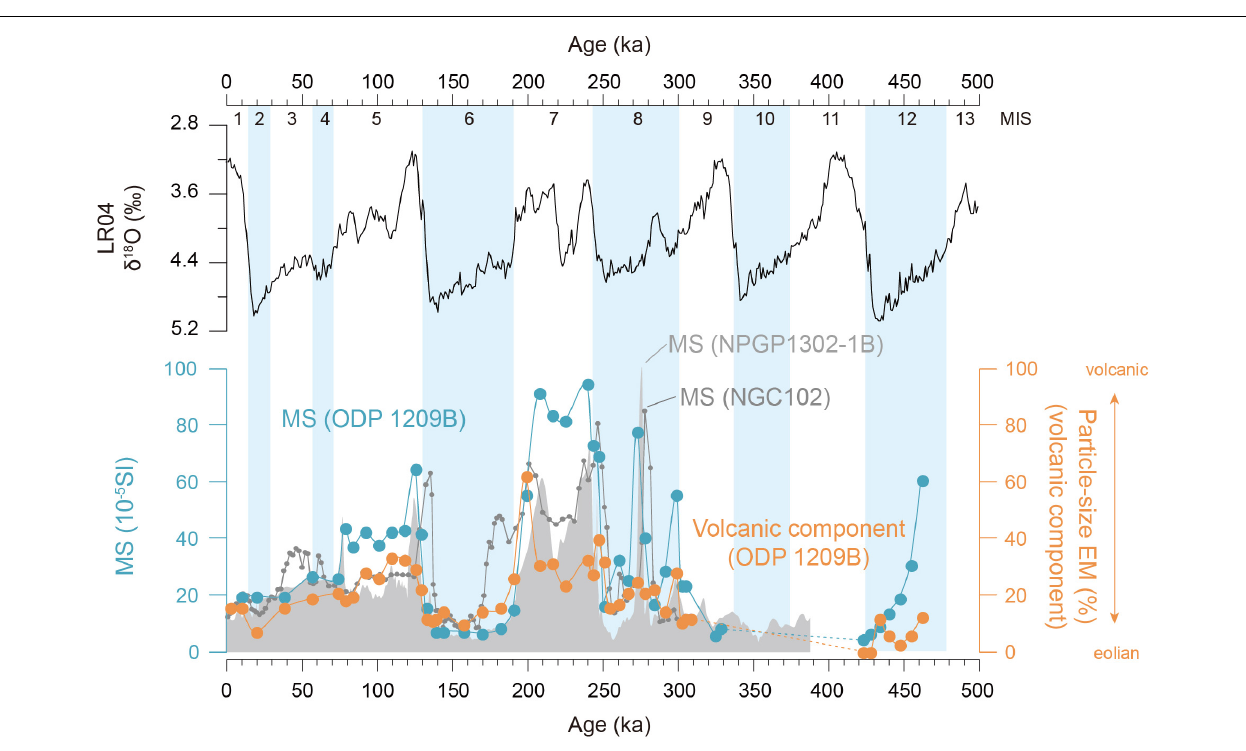
FIGURE 7 | Comparison of global oxygen isotope (LR04; Lisiecki and Raymo, 2005), magnetic susceptibility (MS) of ODP site 1209B (blue; Westerhold and Röhl, 2006; Bordiga et al., 2013 for age construction), particle size endmember (EM) contribution in ODP site 1209B (orange; Zhang et al., 2019), and MS records of NGC102 (dark gray; Yamamoto et al., 2007) and NPGP1302-1B (gray shaded; Shin et al., 2018). The EM corresponds to volcanic component relative to eolian dust in terrigenous fraction of ODP site